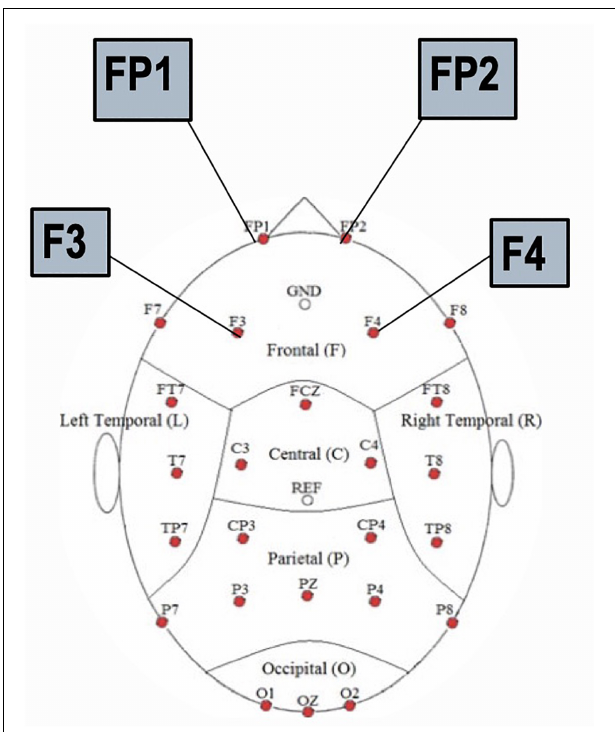
FIGURE 2 | Locations of the frontal electrodes FP1, FP2, F3, and F4 on the 32 channel EEG cap.